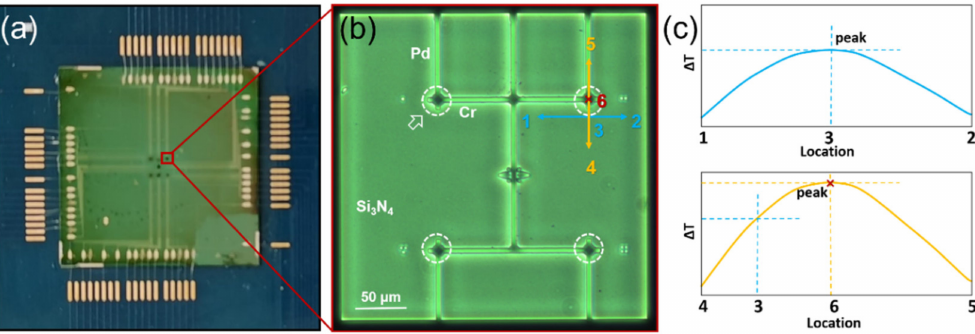
Figure 2. The precise positioning method. ( a ) A diagram of devices for temperature measurement; ( b ) photograph of the Pd/Cr thin film thermocouple array on a Si3N4 freestanding window; ( c ) the voltage output of the thermocouple when fine-tuning the position of laser fiber, in which the upper is related to tuning along blue direction and the lower is along the orange line in ( b ).